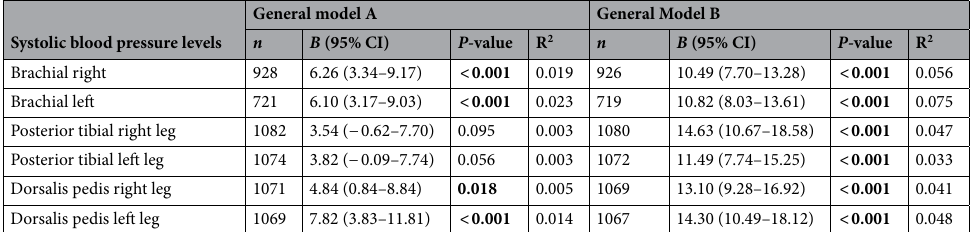
Table 3. Beta ( B ) coefficients for six systolic blood pressure levels to cardiovascular disease and diabetes status using linear regression model. General model A: cardiovascular disease status; General model B: Diabetes status.